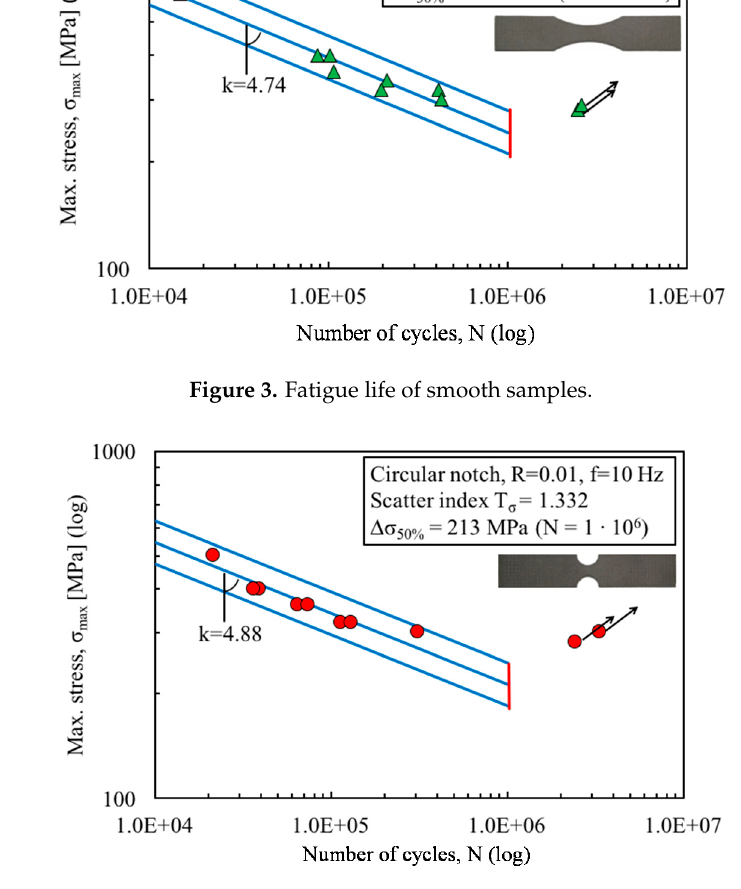
Figure 4. Fatigue life of double blunt V-notched samples.